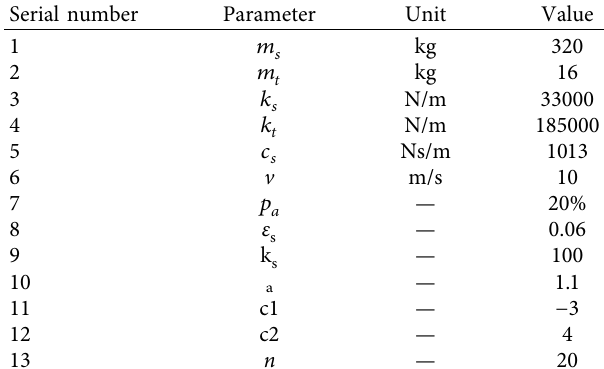
Figure 2: Optimization scheme. Table 1: Suspension parameters.